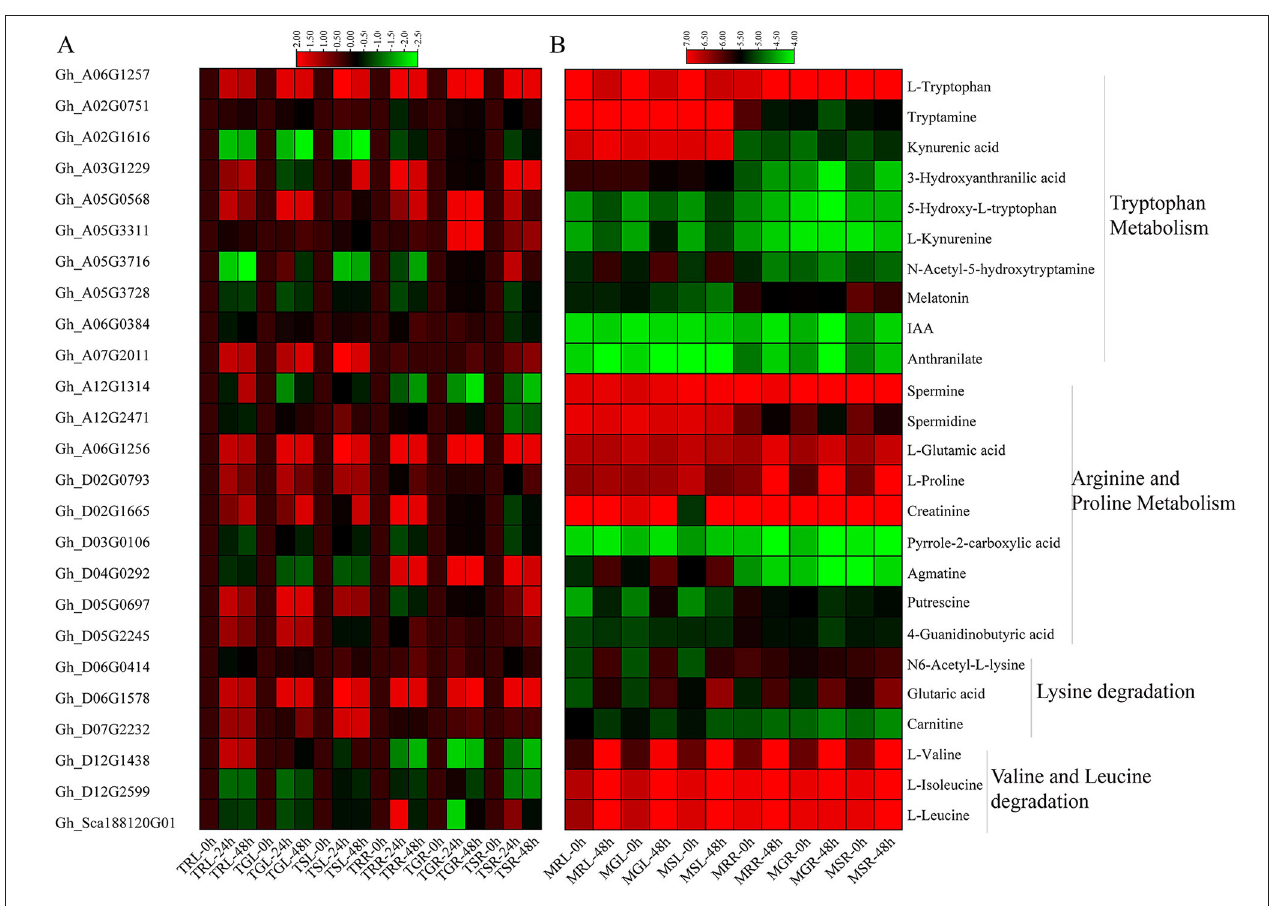
FIGURE 11 | Heatmap of gene expression and expression patterns of metabolites enriched KEGG pathways. (A) Expression profiles of key genes involved in metabolic pathways. (B) The relative expression levels of metabolites based on log10 values using metabolome data in different pathways. KEGG, Kyoto encyclopedia of genes and